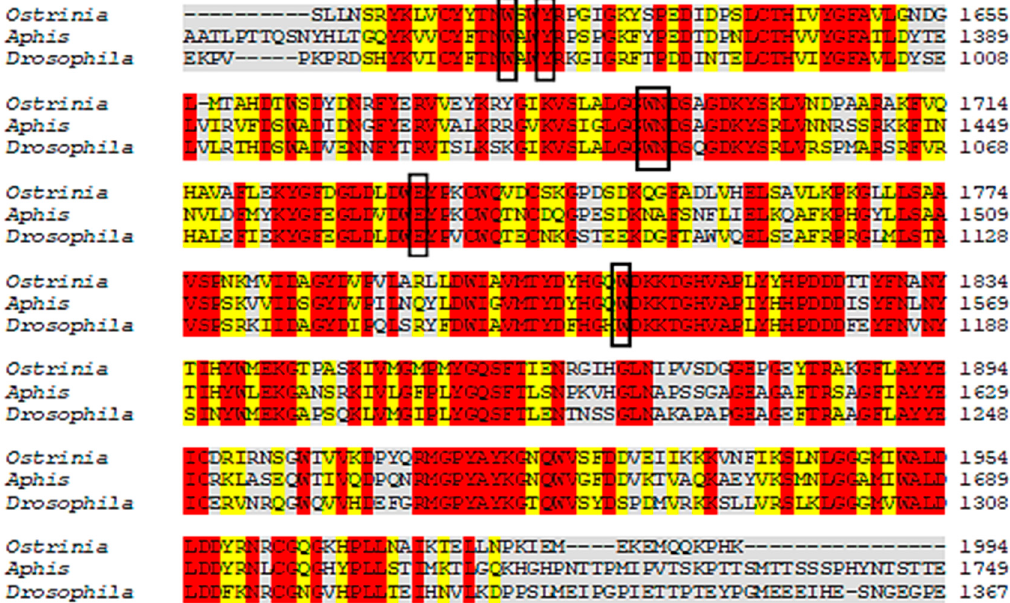
Figure 4. Alignment of Ostrinia furnicalis , A. gossypii, and D. melanogaster Cht protein sequences. The gray regions represent non-similar and non-identical amino acids. The red regions represent identical amino acids. The yellow regions represent similar amino acids. The black boxes represent conserved regions of the active site which bind to the inhibitor.